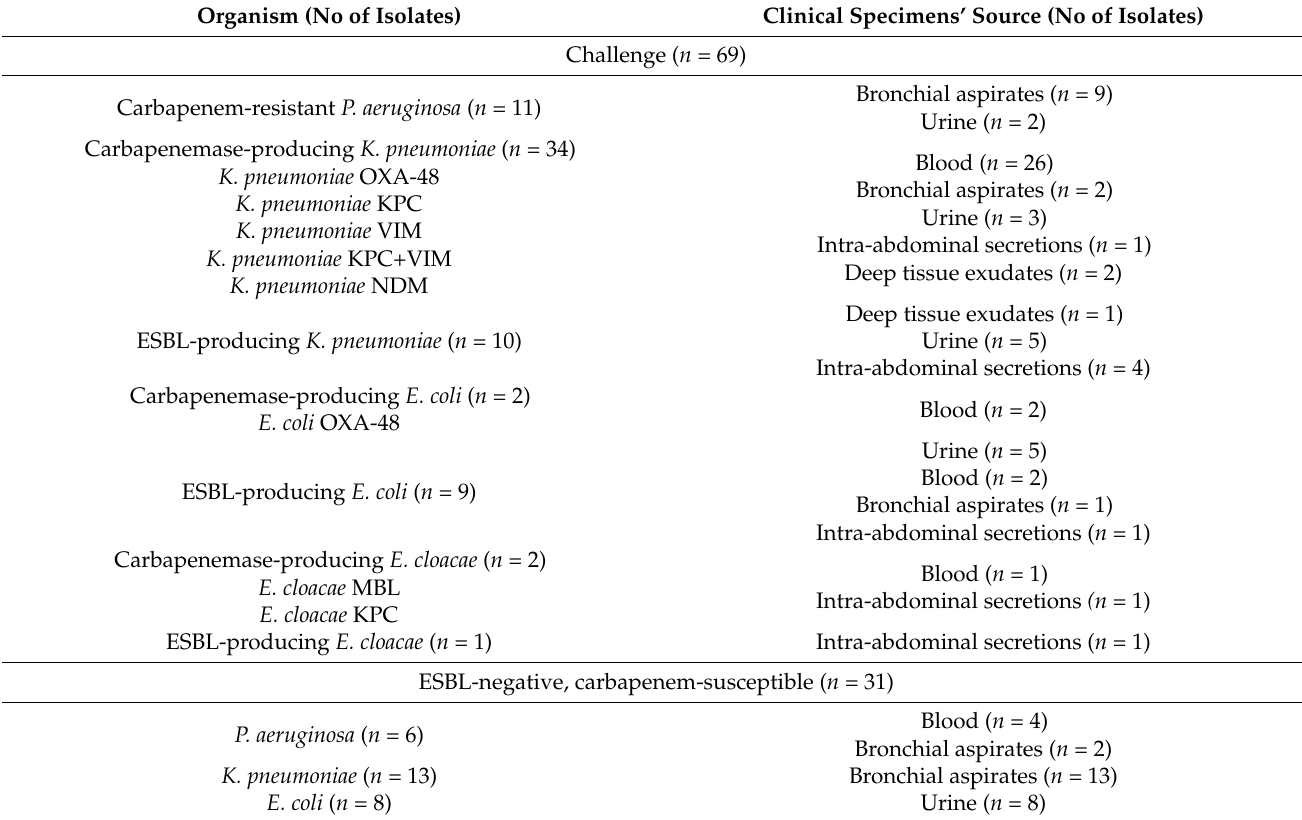
Table 1. Clinical specimens’ source and distribution of bacterial